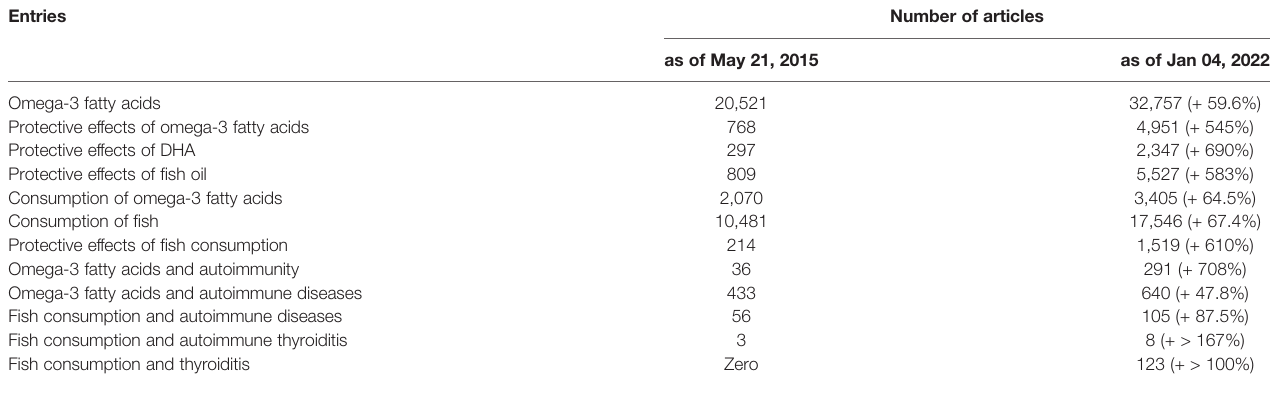
TABLE 1 | Magnitude of the literature retrievable on PubMed at two indicative time